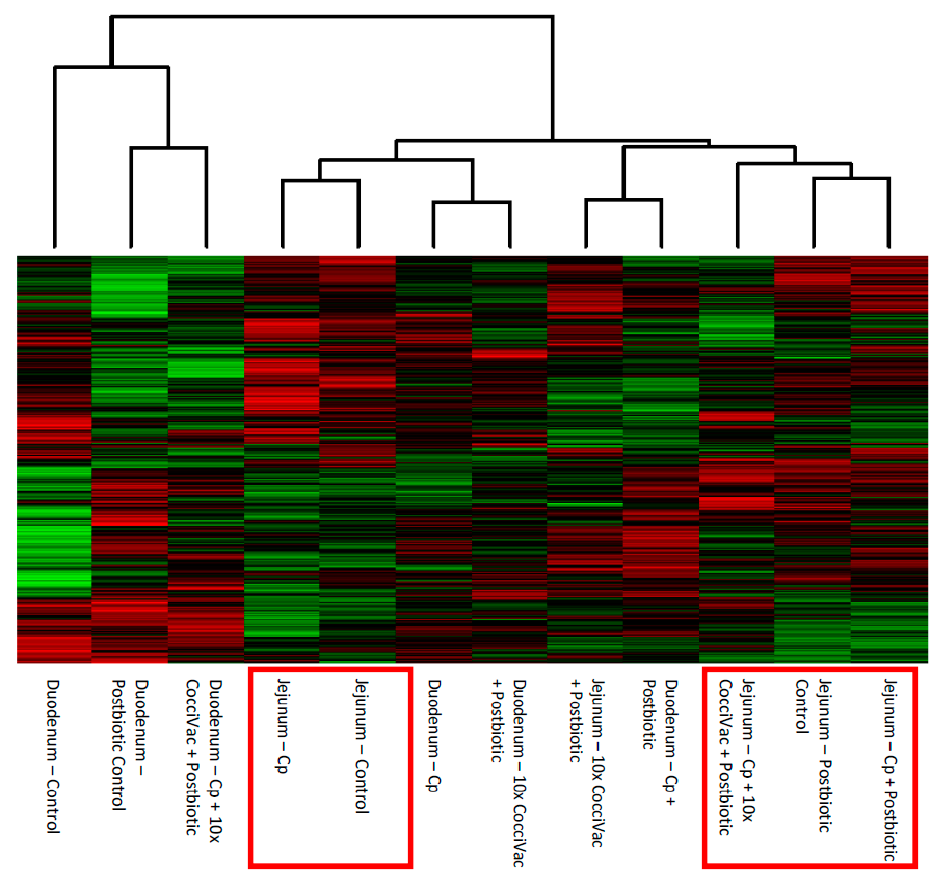
Figure 1. Heatmap and Clustering of Kinome Profiles. The raw kinome signal from the peptide array was input into the custom software package PIIKA 2. PIIKA 2 combines the biological replicates for each treatment and tissue, normalizes the data, and generates a representative kinome profile. Here, the profiles are compared for relative similarity, and a heatmap shows the relative phosphorylation of each peptide on the array. Cp = C. perfringens .